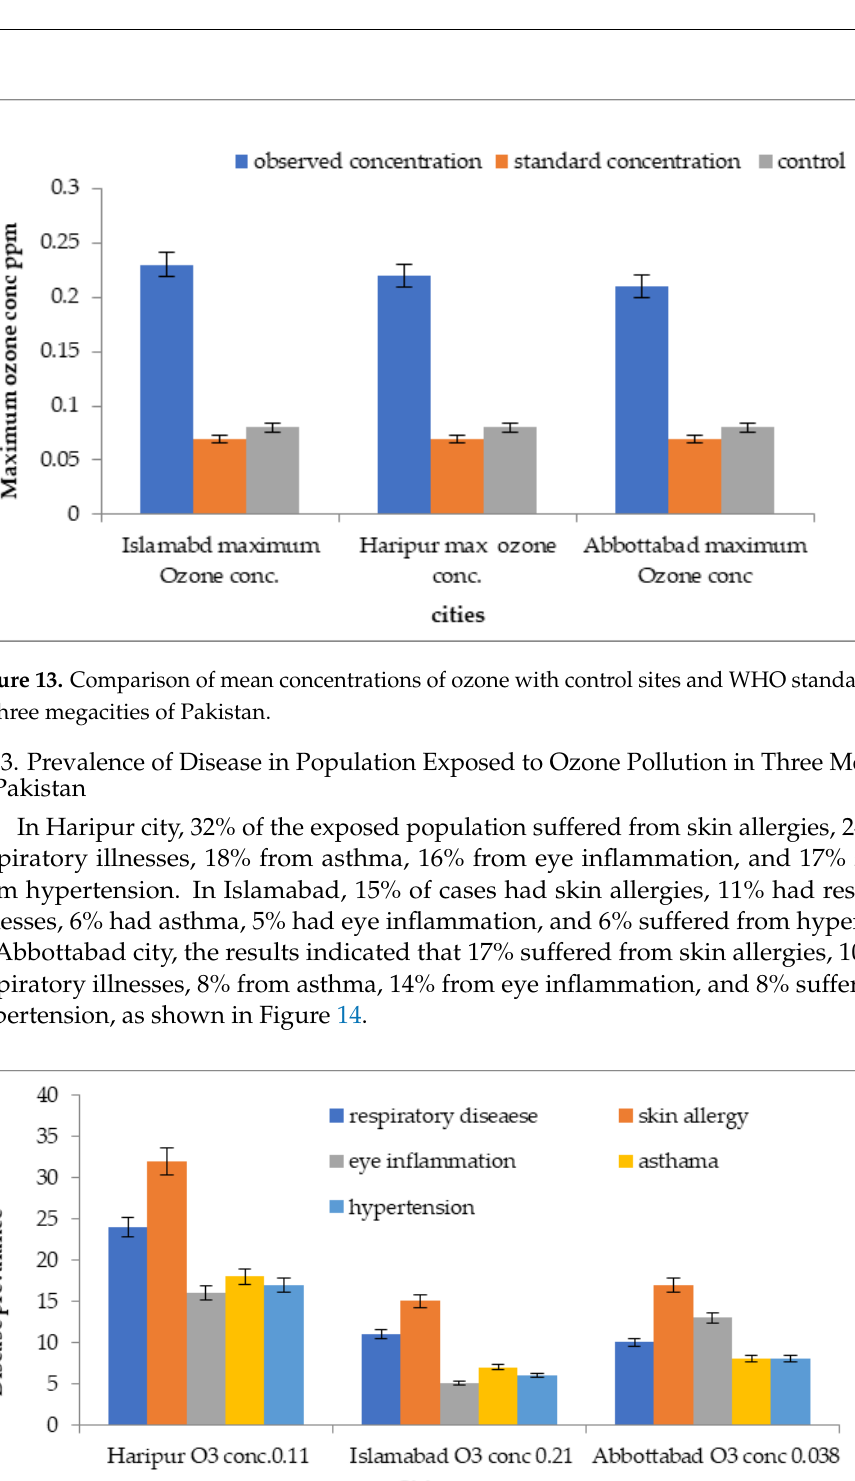
11 of 18 Figure 12. Comparison of maximum and minimum ozone concentrations with control sites and WHO standard values in Abbottabad.